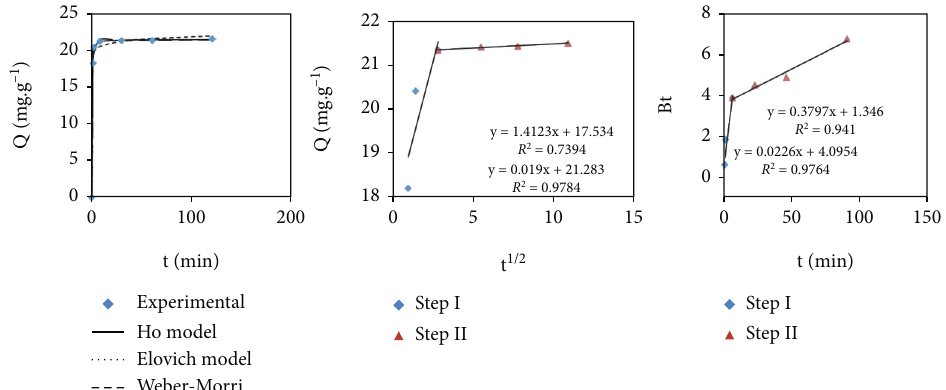
Figure 6: Experimental curves and the models of Ho, Elovich, and Webber-Morri models of the kinetic study of adsorption of the Cu(II) ion in ferric clay.